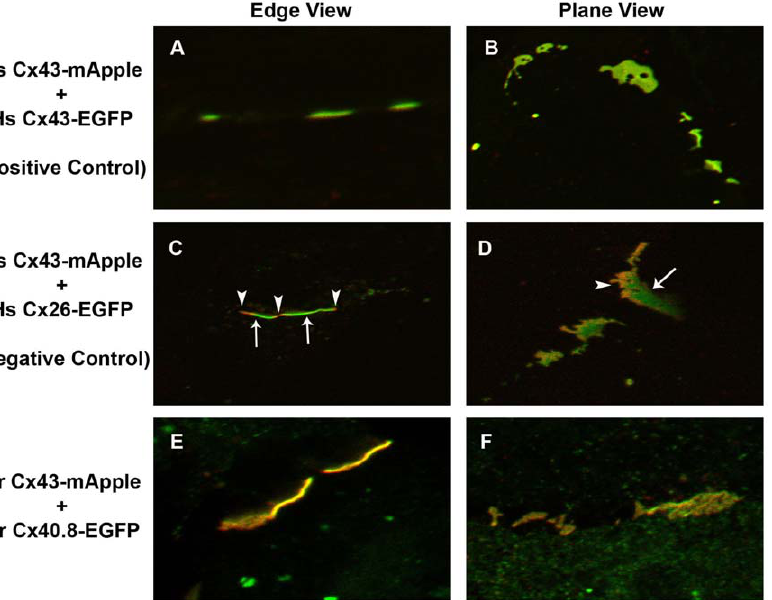
Figure 7. Cx43-mApple and Cx40.8-EGFP co-assemble in common gap junction channels. High resolution fluorescence microscopy was used to provide evidence for co-association of Cx43-mApple and Cx40.8-EGFP in common gap junction channels. Constructs that were co-transfected in HeLa cells are indicated to the left of the panels (A, B) Homo sapiens (Hs) Cx43-mApple + Hs Cx43-EGFP show uniformly yellow plaques, suggesting co-asociation. (C, D) Hs Cx43-mApple + Hs Cx26-EGFP show discrete green and red domains, revealing a lack of co-association. Arrows indicate green Hs Cx26-EGFP localization and arrowheads indicate red Hs Cx43-mApple localization. (E, F) Danio rerio (Dr) Cx43-mApple + Dr Cx40.8-EGFP show uniform yellow